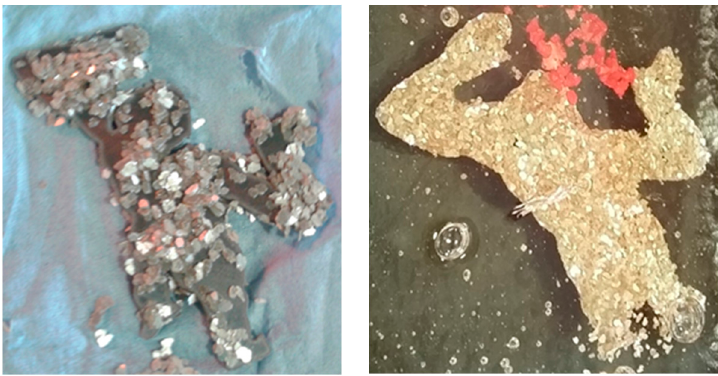
Figure 8. Silver flakes used as a lubricant to prevent oxidation of metal inclusions; created by author.